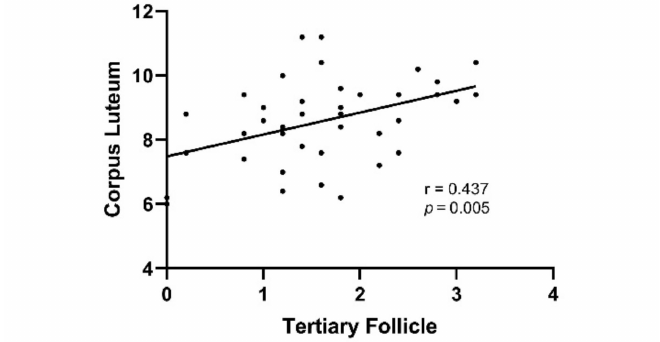
Figure 4. Numbers of tertiary follicles positively correlated with corpus luteum count.